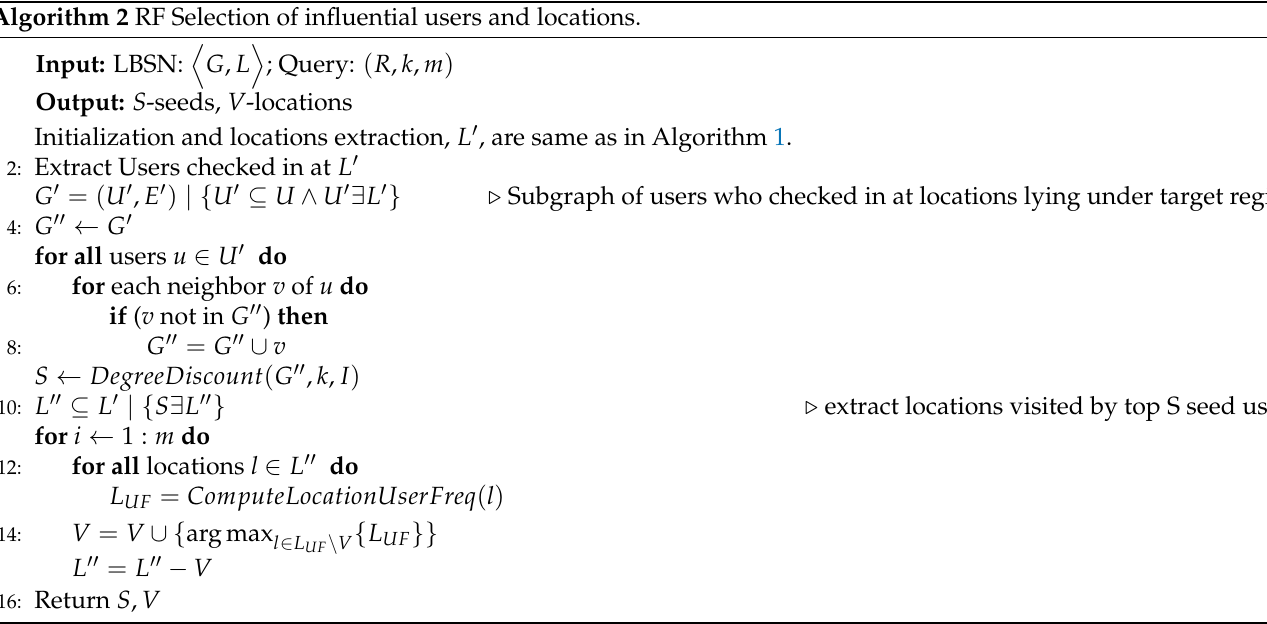
Algorithm 2 RF Selection of influential users and locations.